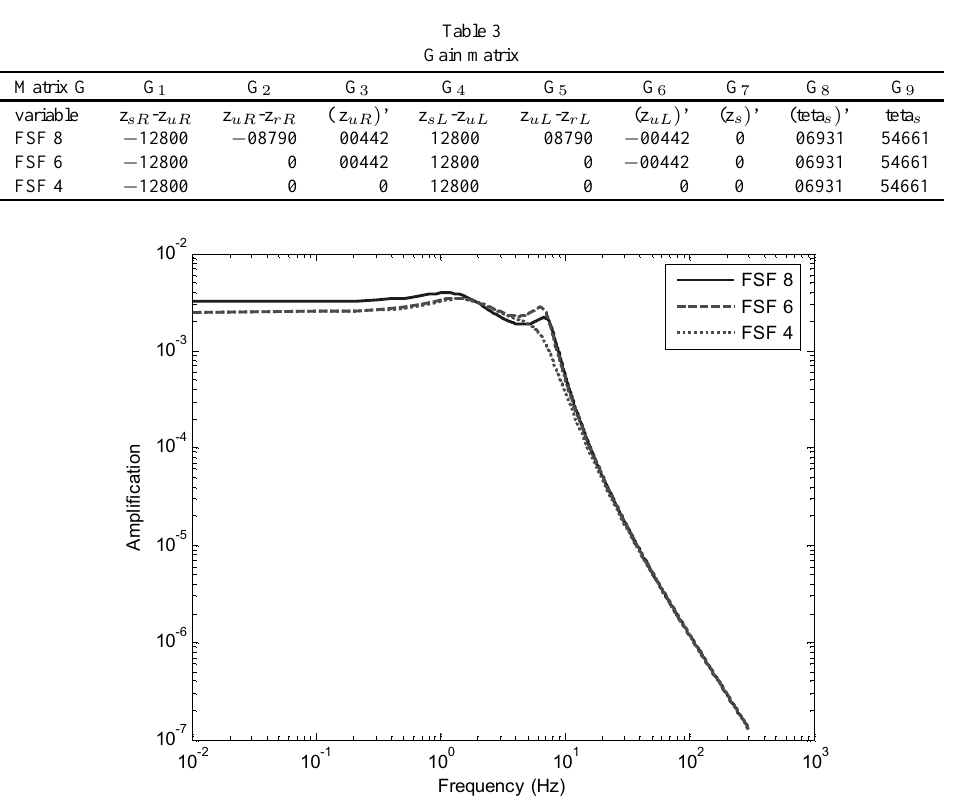
Fig. 6. Suspension deflection for lateral acceleration